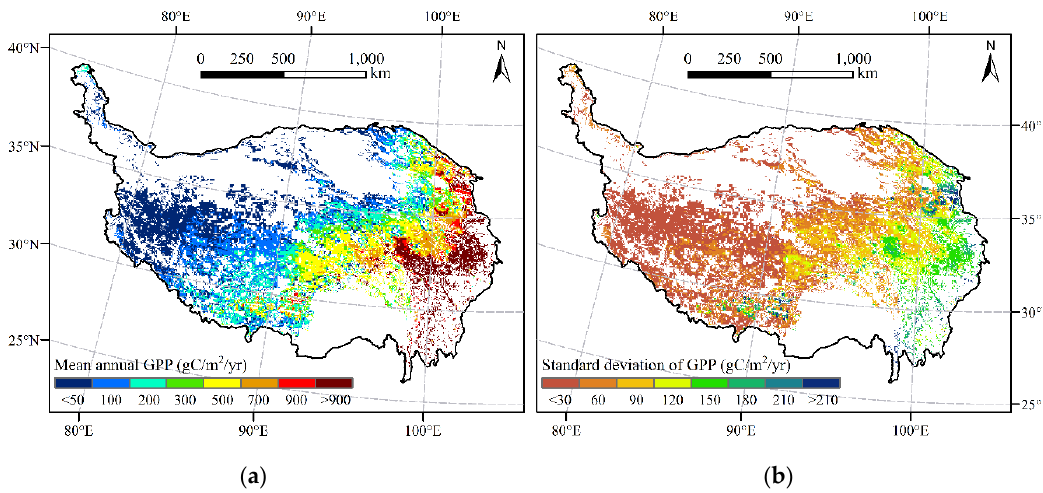
Figure 7. Spatial distribution of mean and standard deviation of GPP of alpine grasslands on the TP from 1982 to 2015. ( a ) Mean annual GPP; ( b ) Standard deviation of GPP.